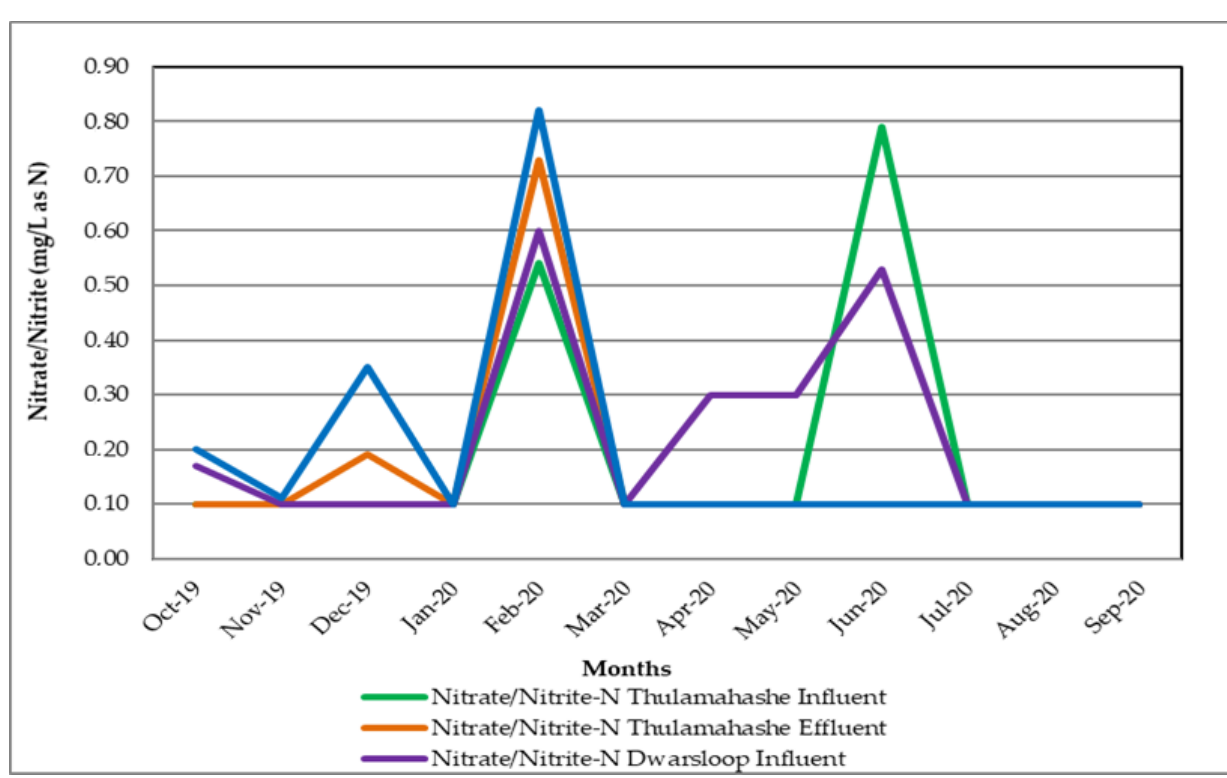
Figure 8. WWTWs performance in terms of Ammonia-Nitrogen.